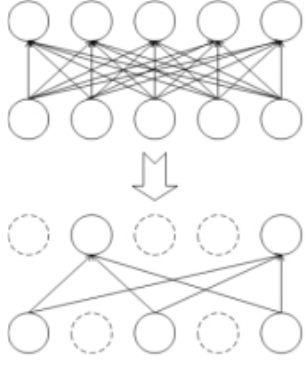
Figure 10. The diagram of